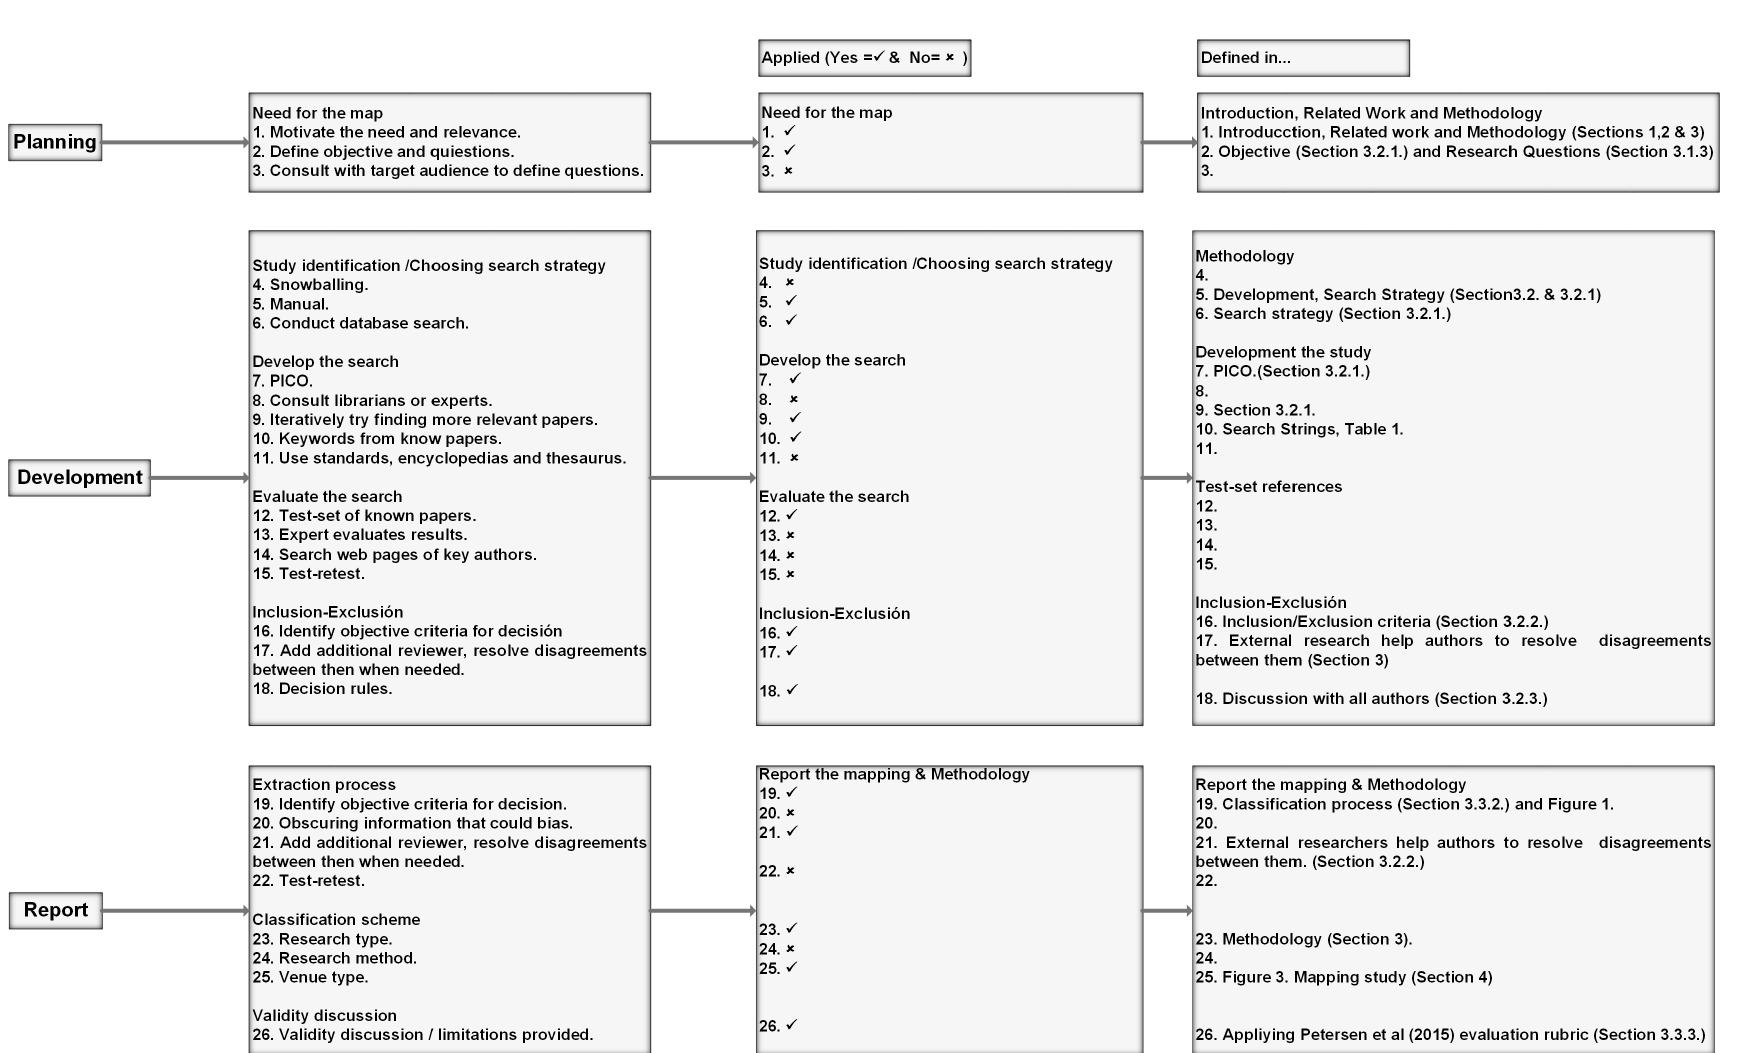
Figure 2. Activities from Petersen et al. [39] evaluation rubric conducted in this systematic mapping study